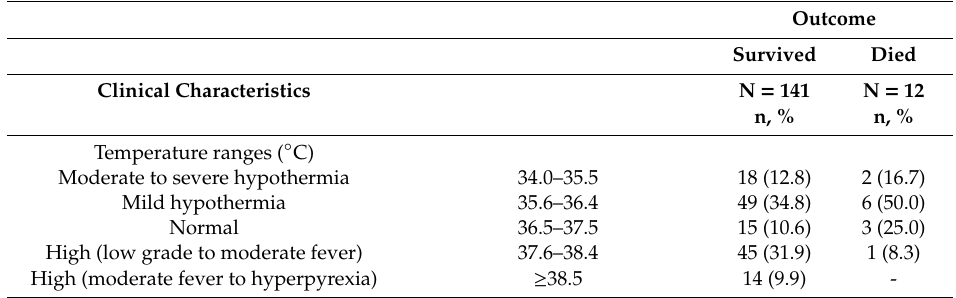
Table 3. Condition and main diagnoses of outborn neonates on arrival at UWRH and SJH.